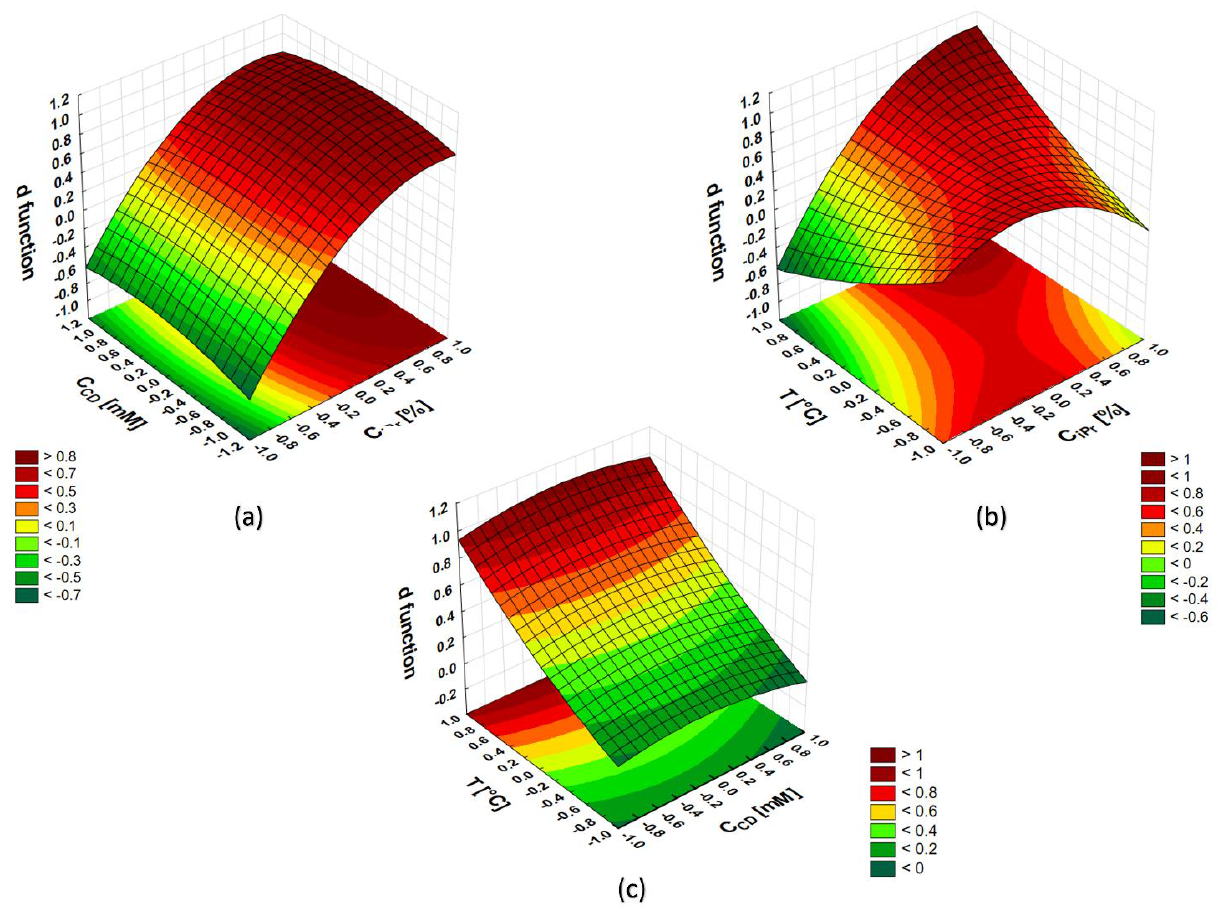
Figure 1. Response surfaces d vs. c iPr and c CD ( a ), d vs. c iPr and T ( b ), d vs. c CD and T ( c ): where c iPr is